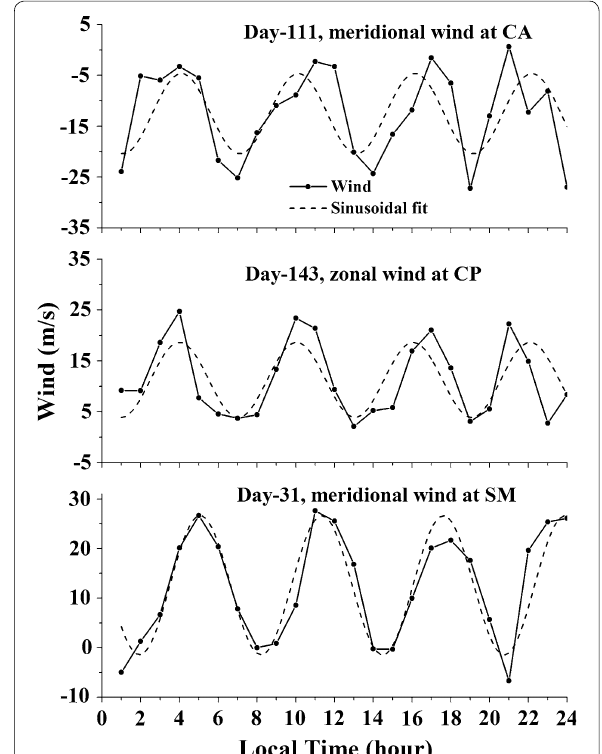
Fig. 1 Typical residual winds at 90 km on removing the diurnal and semidiurnal components show prominent 6-h wave at a CA in the meridional wind on 111 DY, b CP in the zonal wind on 143 DY and c SM in the meridional wind on 31